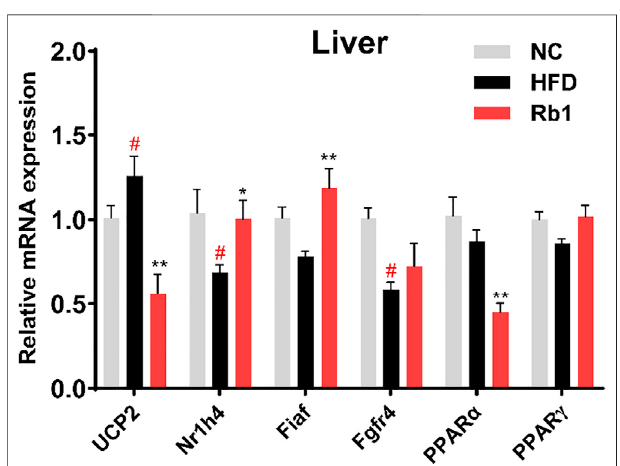
FIGURE 3 | mRNA expression of genes involved in liver were detected byRT-qPCR.Relativeexpressionwascalculatedusingthe2 ΔΔ CT methodwith chowmiceasthegroupofreferenceandGADPHasreferencegene.Thedata are expressed as the mean ± SEM; n (cid:1) 6; one-way analysis of variance with Tukey ’ s post-hoc test. # p < 0.05, ## p < 0.01, for NC vs HFD; * p < 0.05, ** p < 0.01 for Rb1 vs